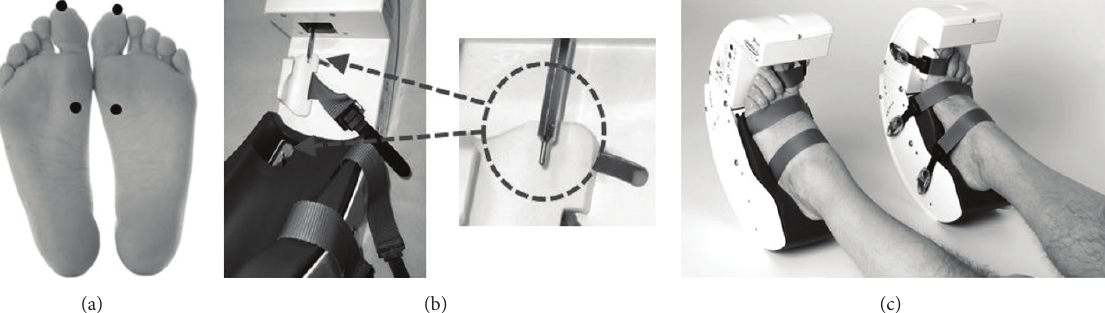
Figure 1: The device used for the AMPS treatment: (a) the specific points of feet stimulation; (b) the two moving steel bars; (c) patient